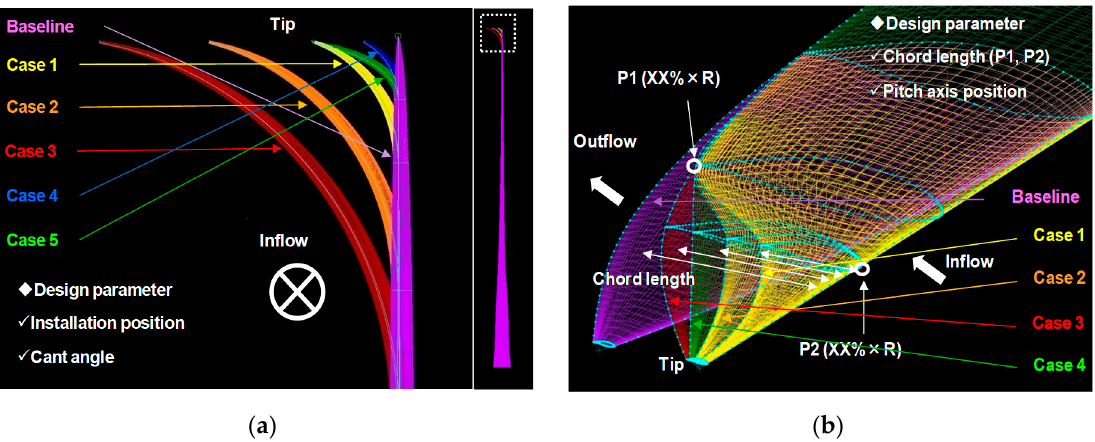
Figure 12. Blade tip designs: winglet and ogee type. ( a ) Winglet tip, ( b ) ogee tip.